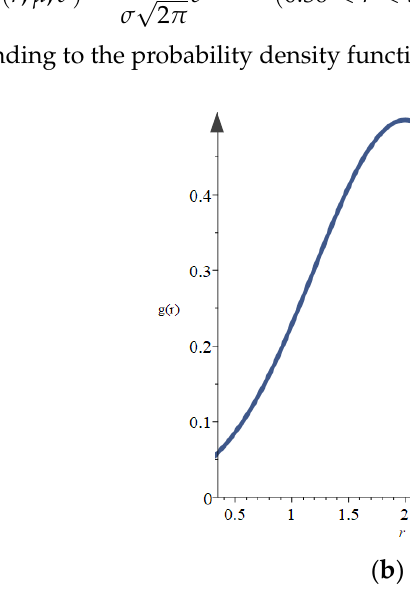
Figure 10. Probability density function of different utilization rates: ( a ) Weibull distribution, ( b ) normal distribution.